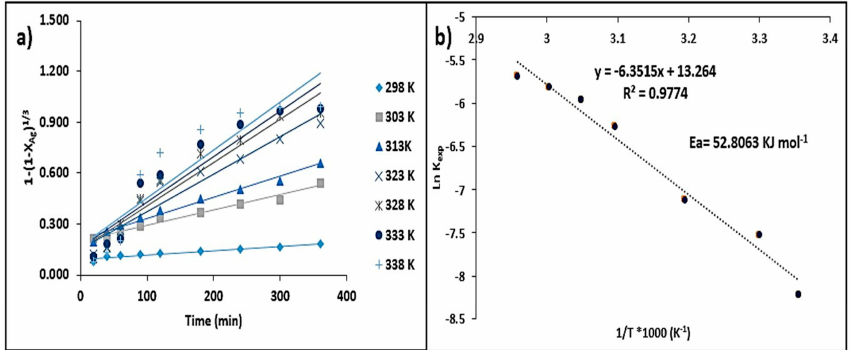
Figure 10. ( a ) Evaluation of the chemical control model on the Ag conversion values as a function of time in order to study the temperature effect. V = 0.5 L, Mineral = 40 g ∙ L − 1 , P O2 = 1 atm, pH = 9, t r = 360 min, d = 74 μ m, [S 2 O 32 − ] = 0.5 mol ∙ L − 1 , [OH − ] = 0.1 mol ∙ L − 1 , RPM = 670 min − 1 . ( b ) Dependence of k exp as a function of temperature. Activation energy, E a = 52.8 kJ ∙ mol − 1 .